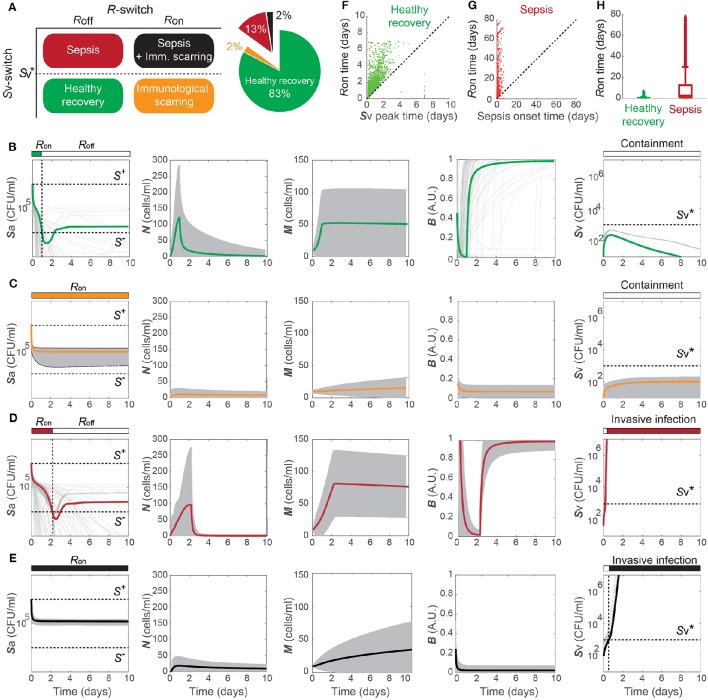
Four phenotypes resulting from alterations in the Sp-host interactions. (A) Four (a healthy and three pathological) phenotypes determined by the states of R- and Sv-switches, and their respective frequency of observation in 10, 000 simulations with varying parameters for our model. The states of the R- and Sv-switches determine whether host response persists causing immunological scarring, and whether sepsis occurs, respectively. (B–E) The dynamics of the four phenotypes: healthy recovery (B), immunological scarring (C), sepsis (D) and sepsis accompanied with scarring (E). Solid lines and the gray shaded regions correspond to the mean dynamics and the ± standard deviation. (F)
R-switch ON time vs. Time to reach the peak of Sv for the healthy recovery case. (G)
R-switch ON time vs. Time for sepsis onset for the sepsis phenotype. (H) Boxplots representing the minimum, first quartile, median, third quartile, maximum and outlayers of the R-switch ON time for healthy recovery and sepsis cases.